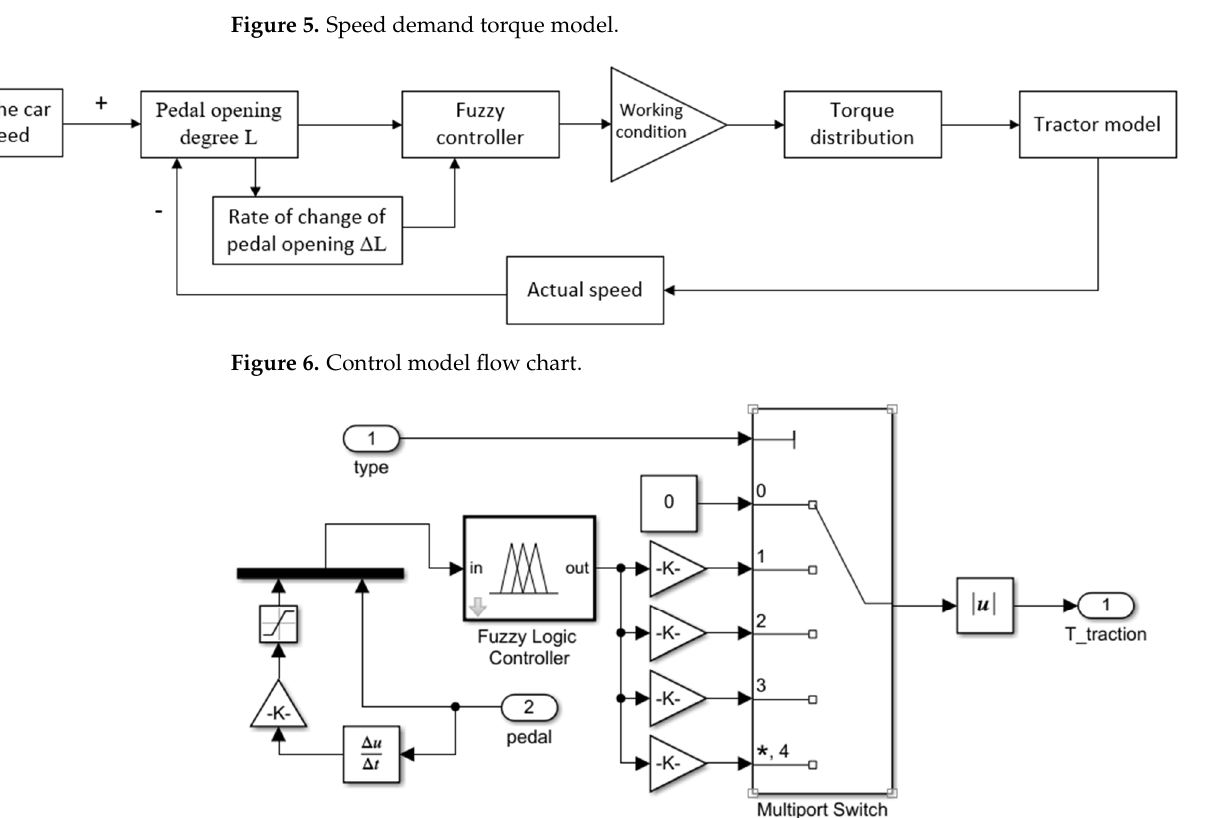
Figure 6. Control model flow chart.